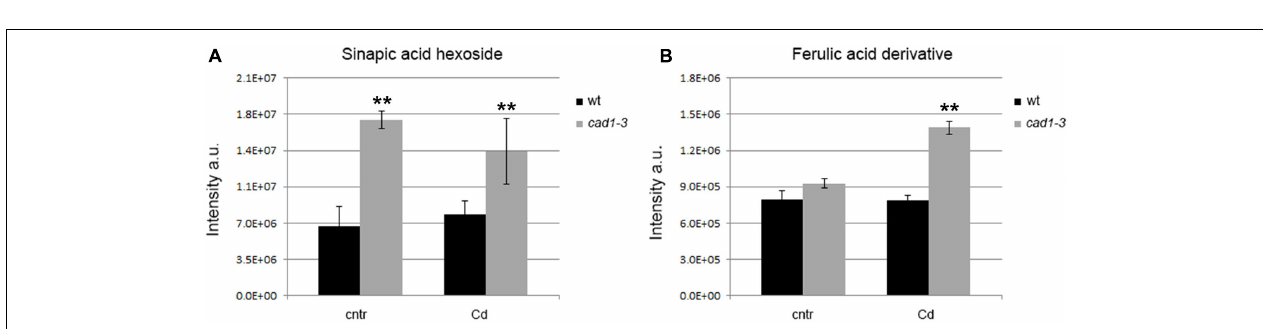
FIGURE 5 | Phenotype of wt, cad1-3 and pen2-1 two-week-old plants grown with 0 (cntr) (A) , 25 (B) , 50 (C) , and 75 µ M (D) CdCl 2 for 14 days. (E) Primary root length of the same plants. n = 14, error bars indicate SE. Statistical analysis was performed for each Cd concentration by one-way ANOVA followed by the Bonferroni’s post hoc test. Different letters indicate statistically significant differences at p ≤ 0.05.